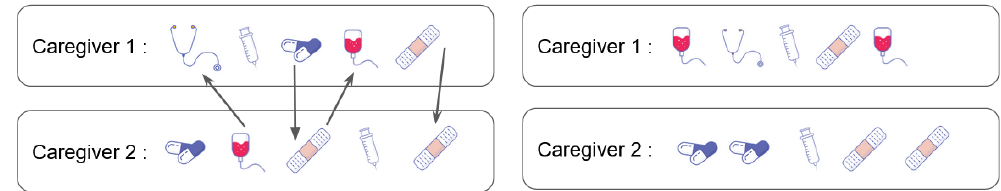
Figure 10. Caregiver neighborhood